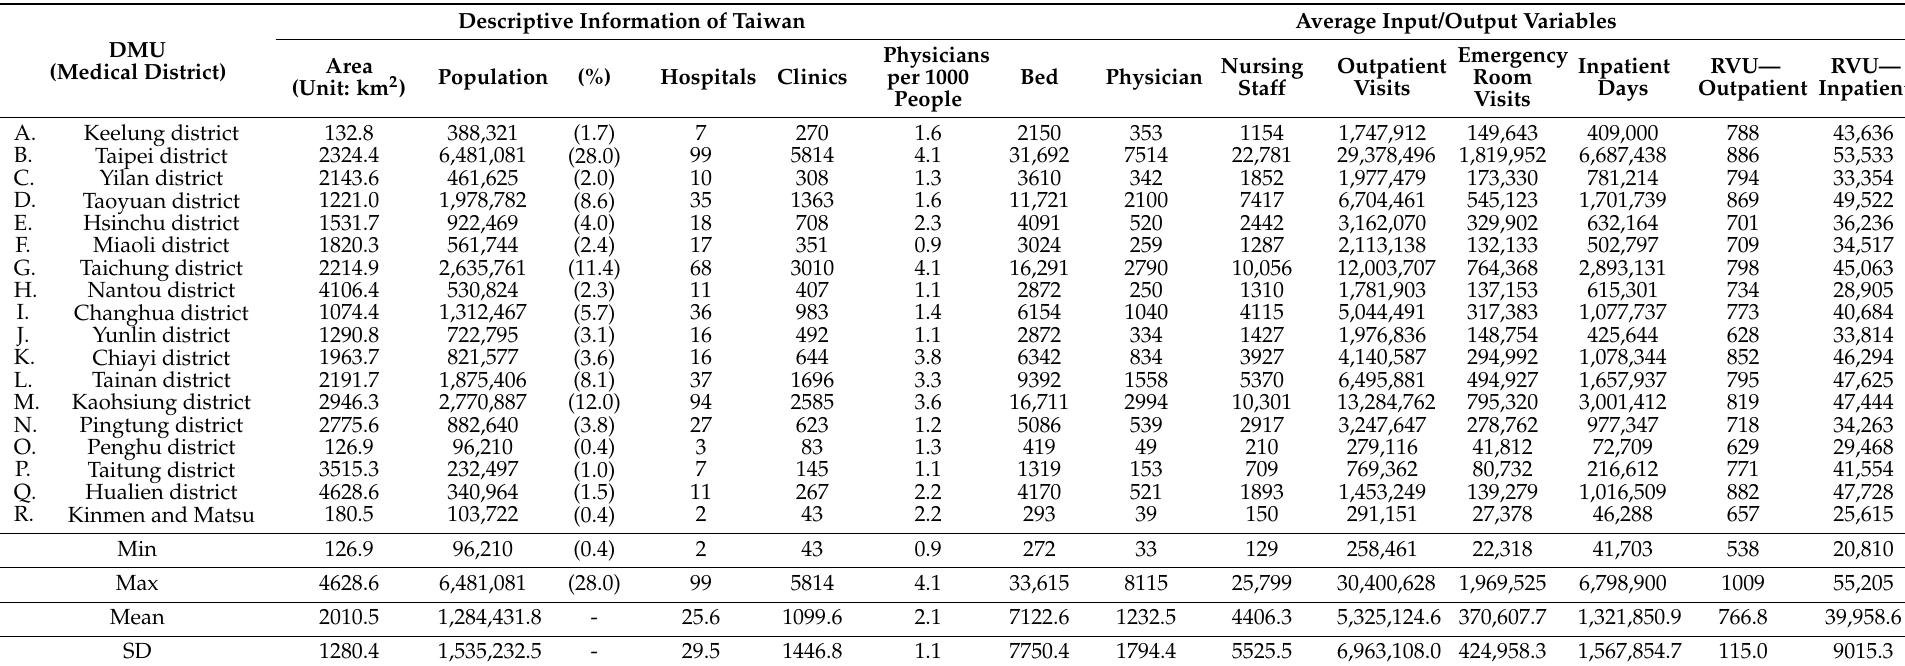
Table 1. Descriptive information of Taiwan and average input/output